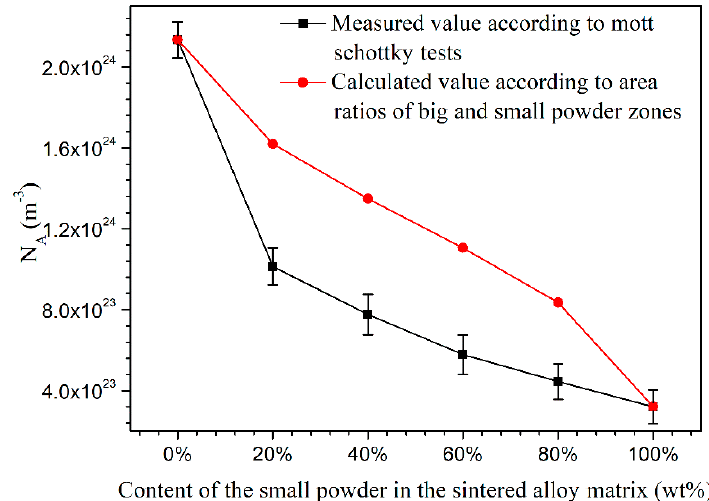
Figure 8. Point defects density in passive films formed on sintered 7075 alloys after 6 h immersion in 0.2 M Na 2 SO 4 + 0.01 M NaCl solution, the standard deviation comes from five valid parallel results.